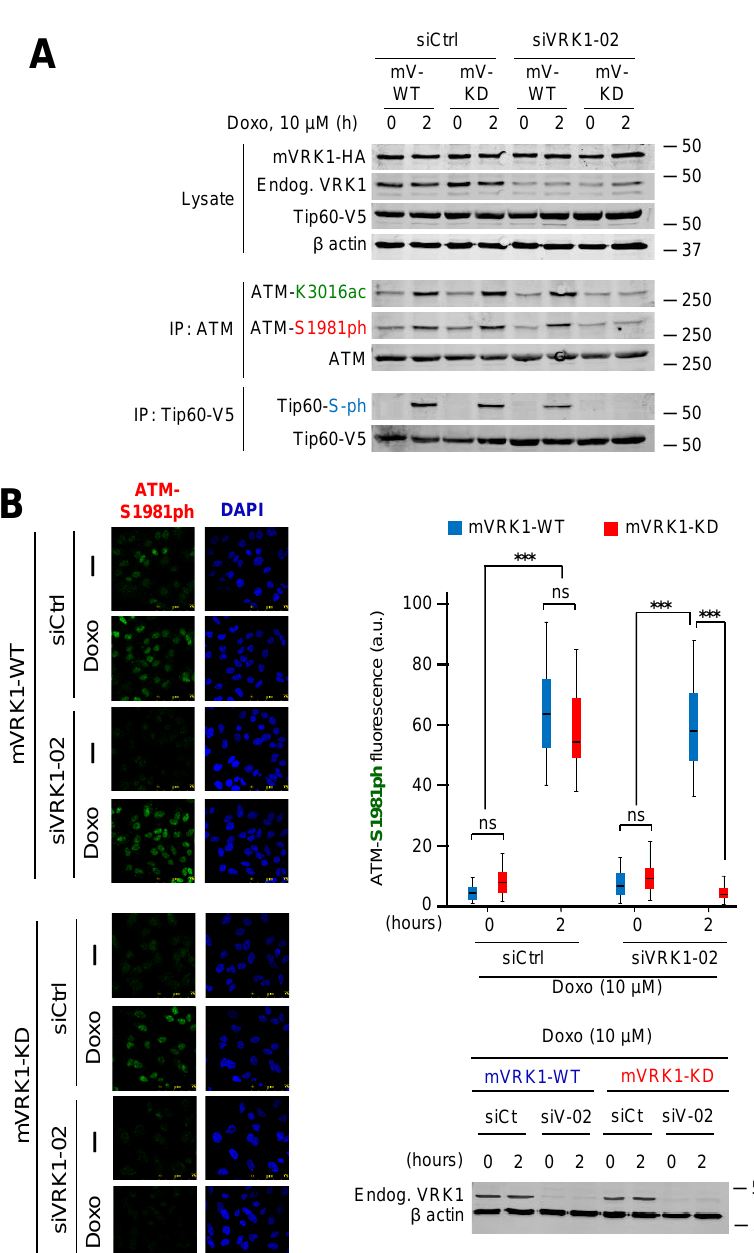
Figure 9. The acetylation and phosphorylation of ATM induced by doxorubicin are rescued by kinase-active VRK1. ( A ). Rescue of ATM acetylation and phosphorylation induced by doxorubicin in A549 stable cell lines expressing kinase-active (mV-WT) (left) or kinase-dead murine VRK1 (K179E) (mV-KD) (right) in which the endogenous human VRK1 was depleted. ( B ). Rescue of ATM phosphorylation induced by doxorubicin in A549 stable cell lines, which express either murine kinase-active (mVRK1) (top) or kinase dead murine VRK1 (K179E) (mVRK1-KD) (bottom), and in which endogenous human VRK1 was depleted. The graph to the right shows the quantification of fifty cells ns: Not significant. *** p <